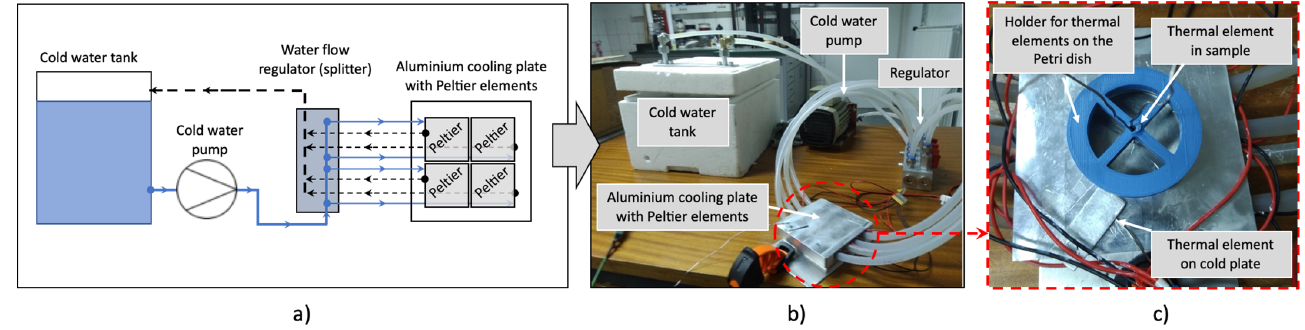
Figure 2. ( a ) Schematic representation of the experimental setup and ( b ) the corresponding digital image of the setup, as well as ( c ) the cryoplatform with the 3D-printed Petri dish and thermocouple holder.